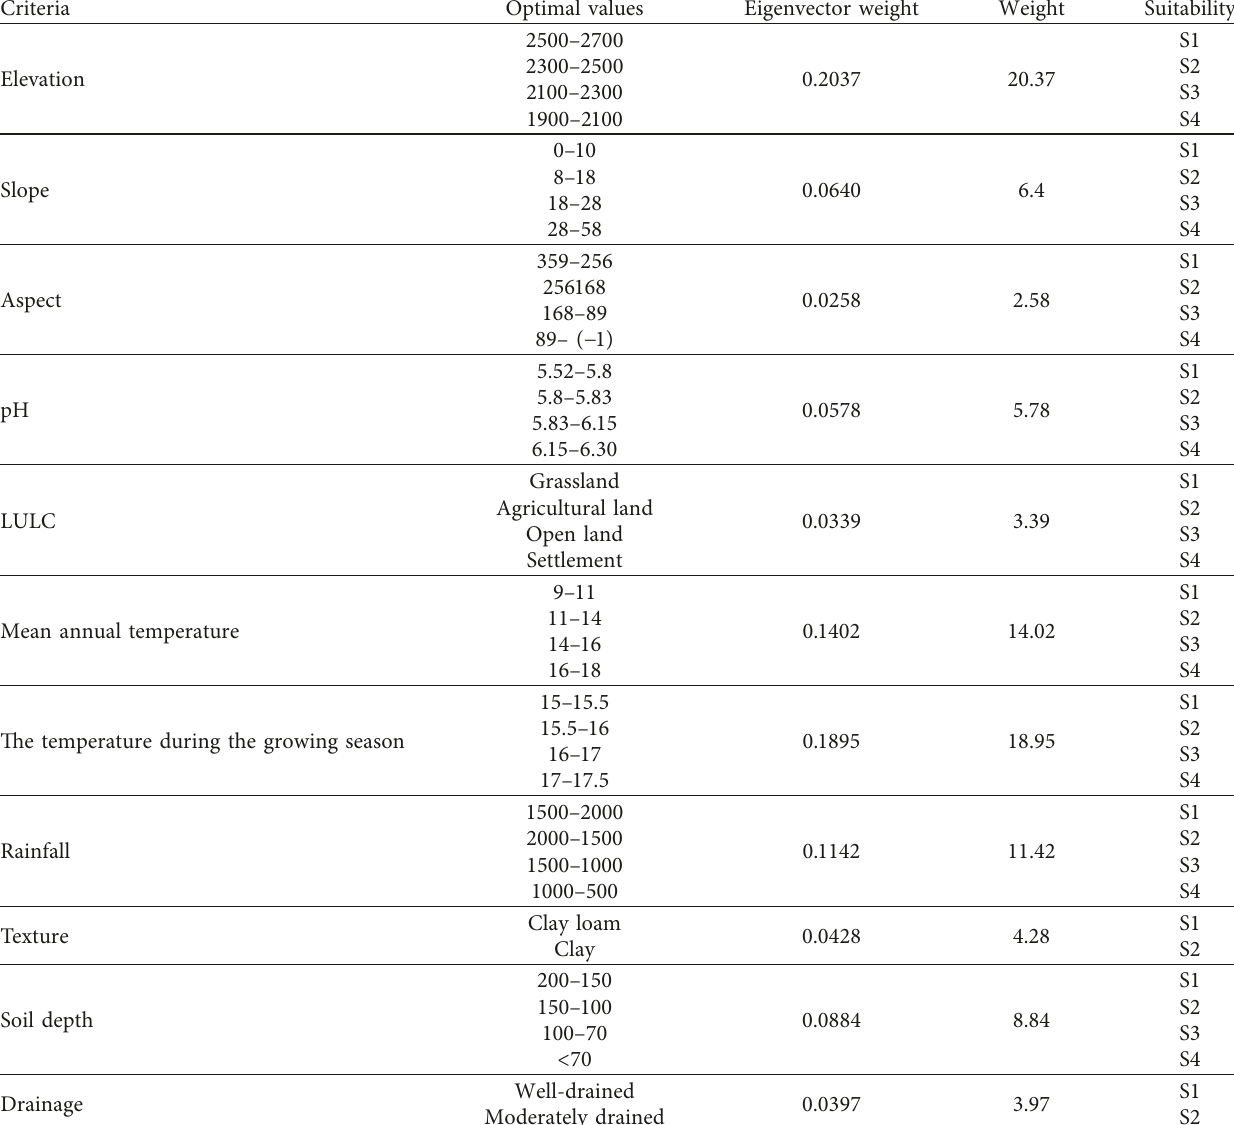
Table 3: Weights of the parameters and scores of sub-parameters.